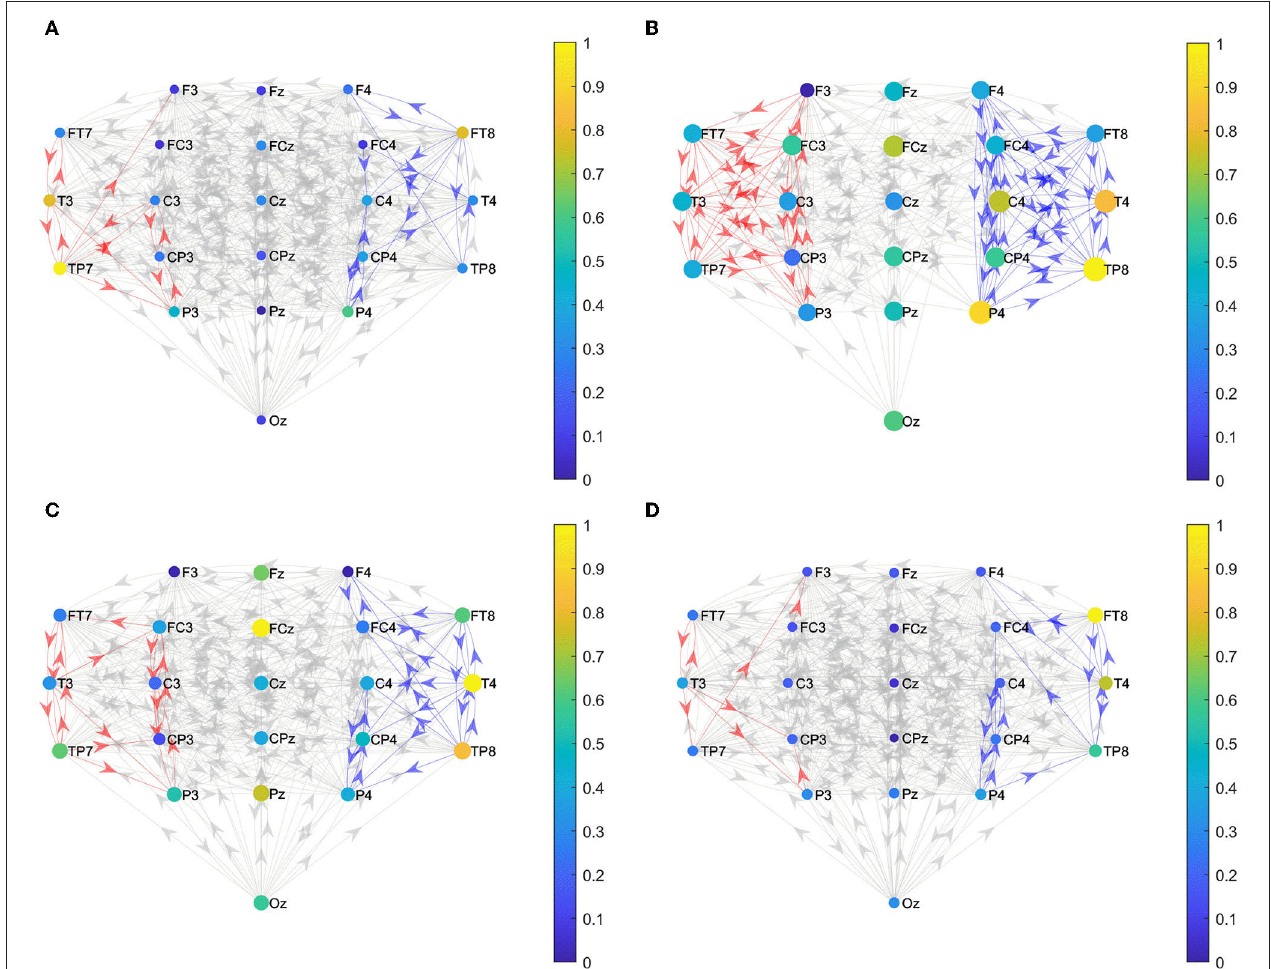
FIGURE 5 | Effective connections within both hemispheres. (A) BCI–FES group before intervention; (B) BCI–FES group after intervention; (C) FES group before intervention; and (D) FES group after intervention. Gray edges indicate connections below the threshold, red edges represent effective connections within the ipsilesional hemisphere, blue edges indicate effective connections within the contralesional hemisphere, node size represents node strength, and node color indicates normalized node strength. The direction of the arrow indicates the direction of information flow.